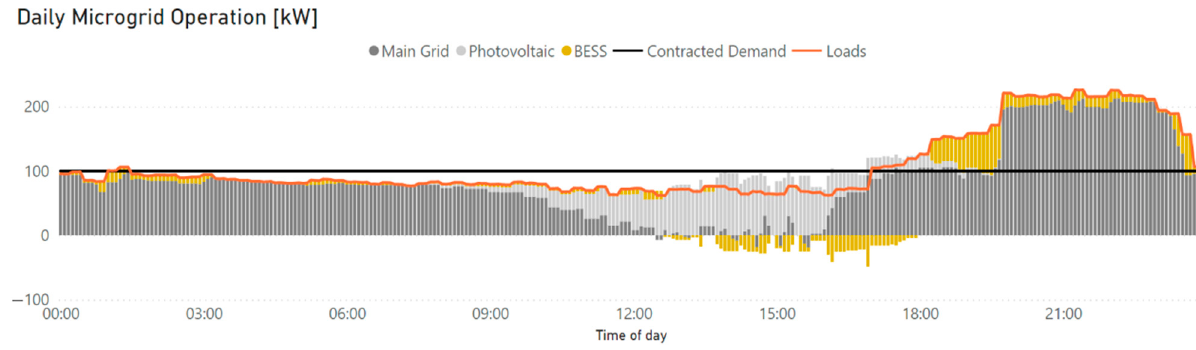
Figure 10. Daily microgrid operation for a contracted demand of 100 kW.